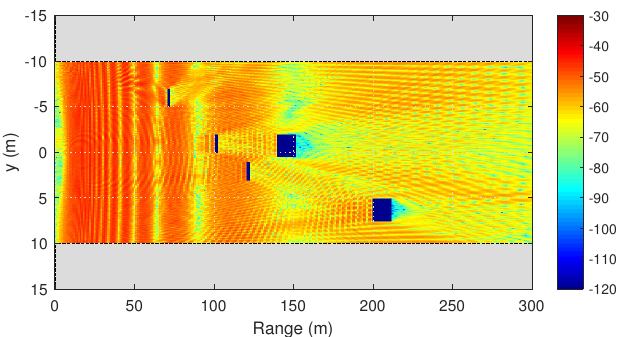
Figure 13. Scattering on vehicles in a street canyon. Two-dimensional distribution of the signal level (dBm) at the height of 1.5 m, calculated by the two-way PE method.